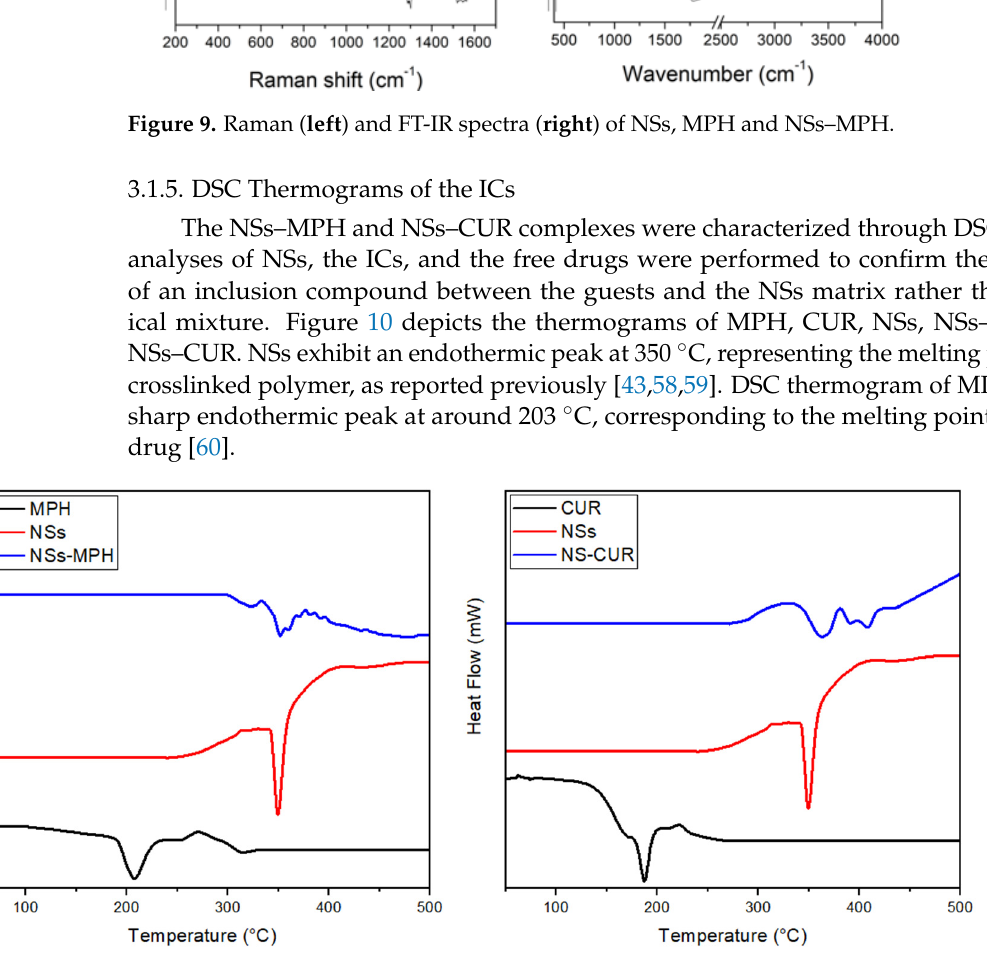
Figure 9. Raman ( left ) and FT-IR spectra ( right ) of NSs, MPH and NSs–MPH.